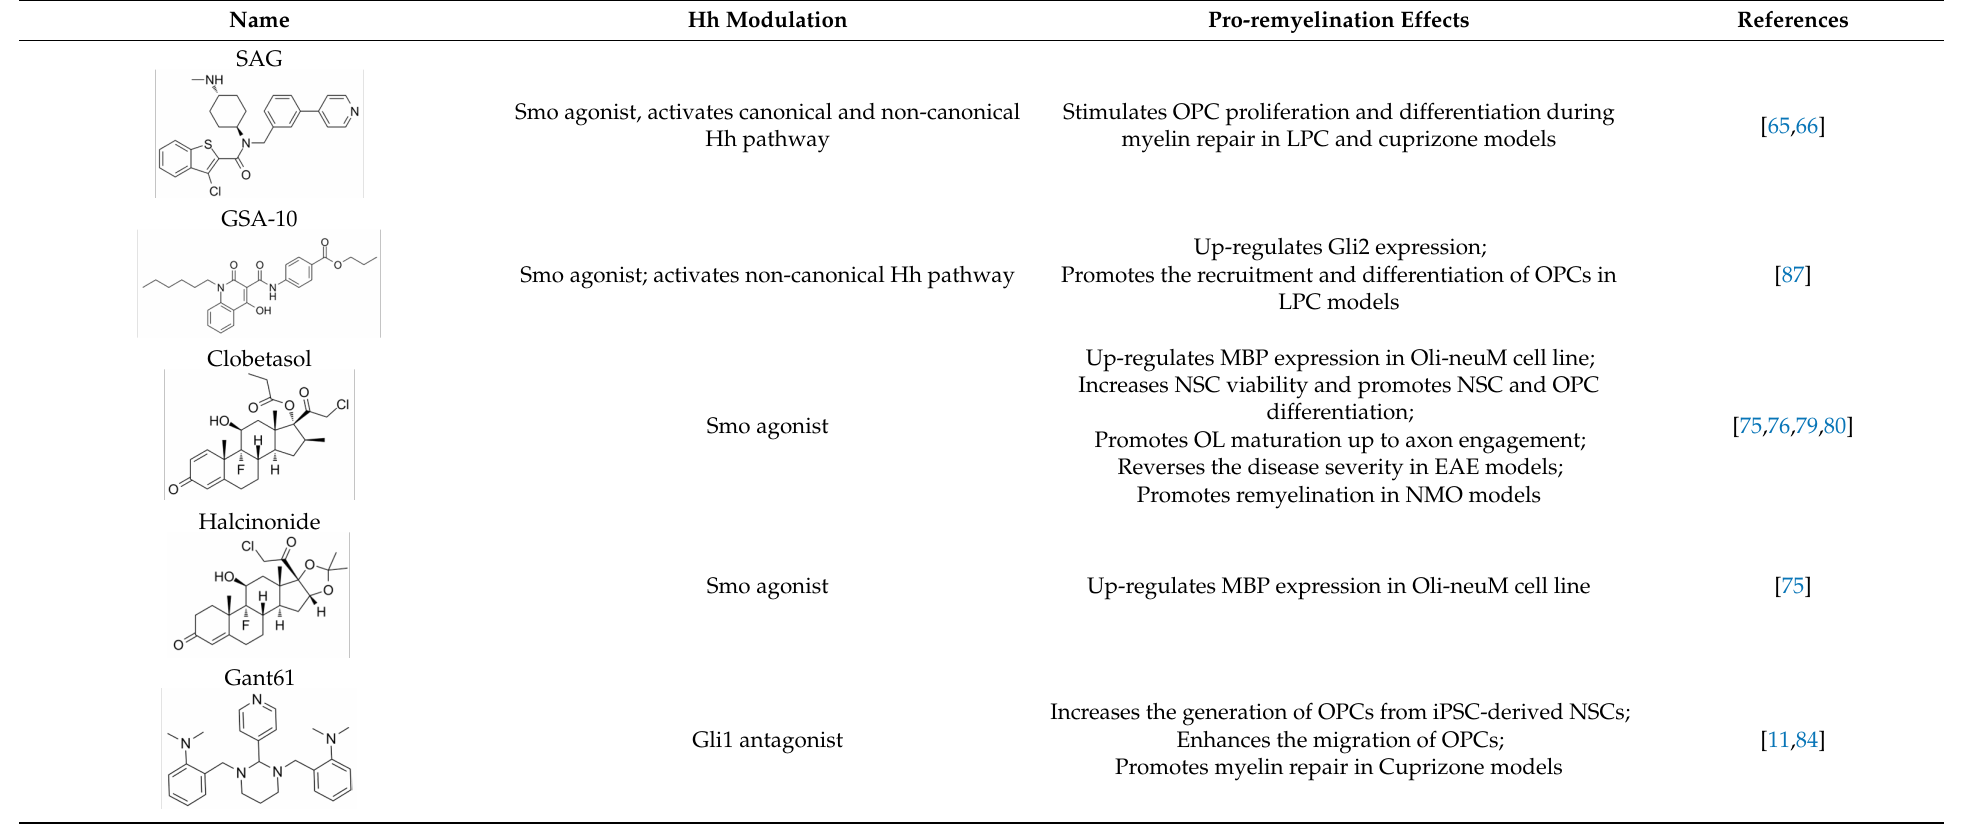
Table 1. Summary of the effects of reported pro-remyelinating Hh